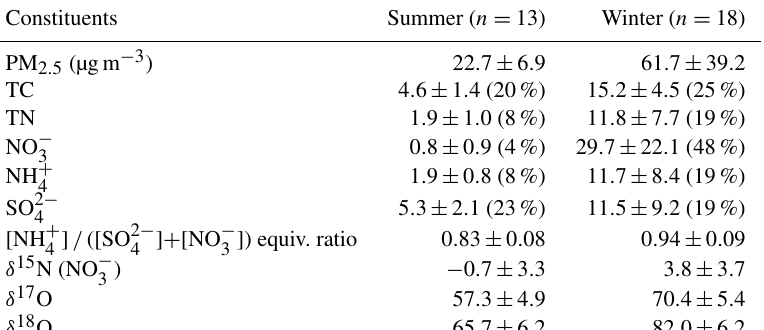
Table 1. Measurement summary of PM 2 . 5 chemical constituents and isotopic compositions in Seoul during the sampling period of May 2018–March 2019. Arithmetic mean ± 1SD (mass fraction, %) for mass concentrations and concentration-weighted mean ± 1SD for isotope ratios.